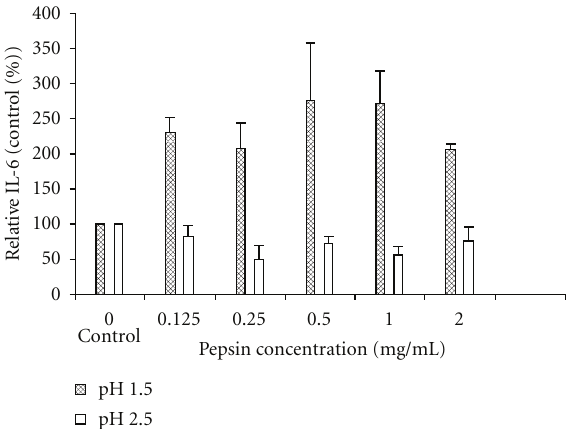
Figure 4: Interleukin-6 production by 16-HBE cells, corrected for cell proliferation and expressed as a % of exposure with the corresponding pH without pepsin (control). Interleukin-6 release induced by pepsin is higher at pH 1.5 compared to pH 2.5 (mean di ff erence 283%; P = 0 . 03). Data are expressed as means (histograms) and SEM (bars) for 3 replicates. See supplement Figure 2 for induction of IL-6 at all pepsin concentrations and pH levels used in the statistical analysis.